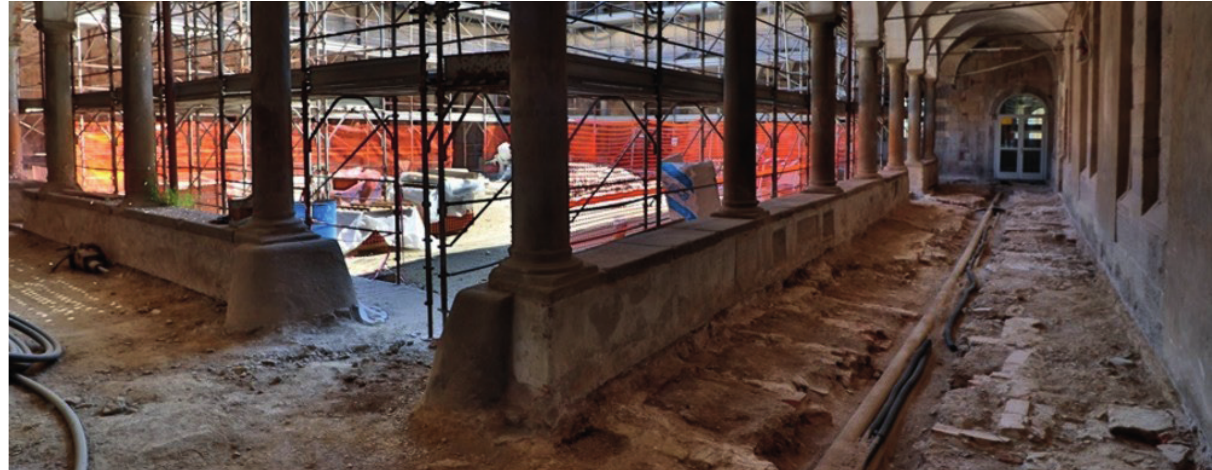
Figure 3. The building site of the small cloister with the tombs and the fragments of epigraphs (©Colleoni,